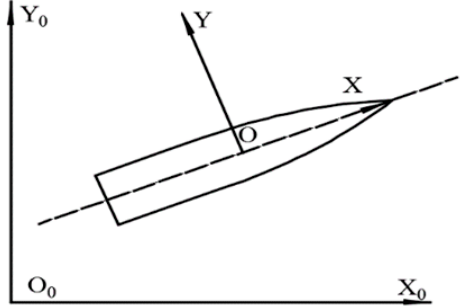
Figure 5. Computational domain and boundary conditions.